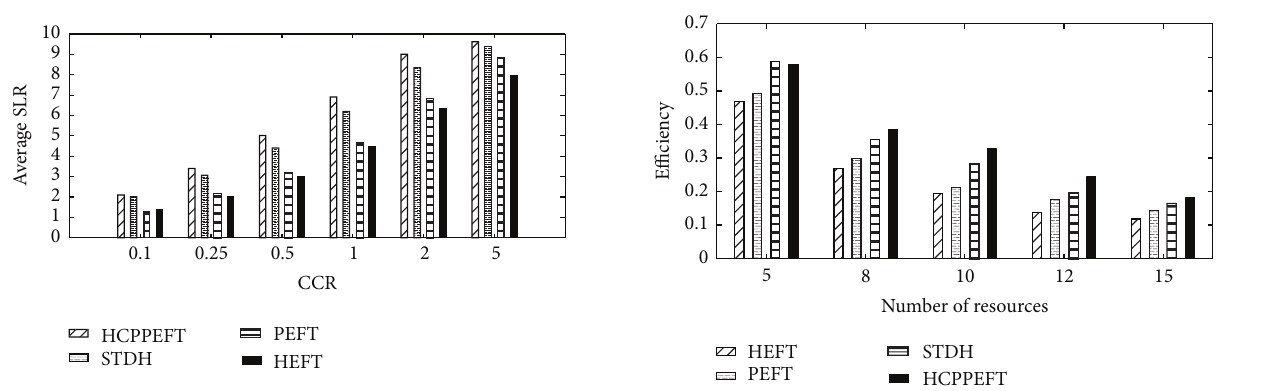
Figure 6: Average SLR with 100 nodes for random task graphs.